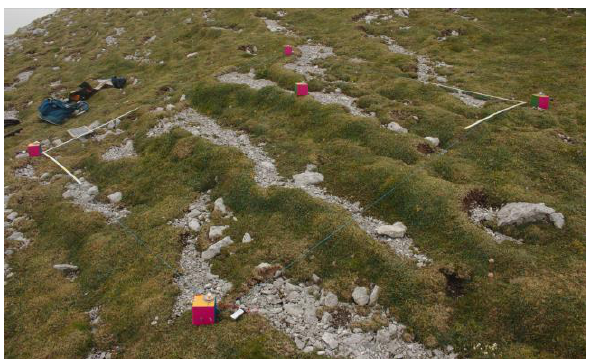
Figure 10. Plot ghk_e45, roughness =